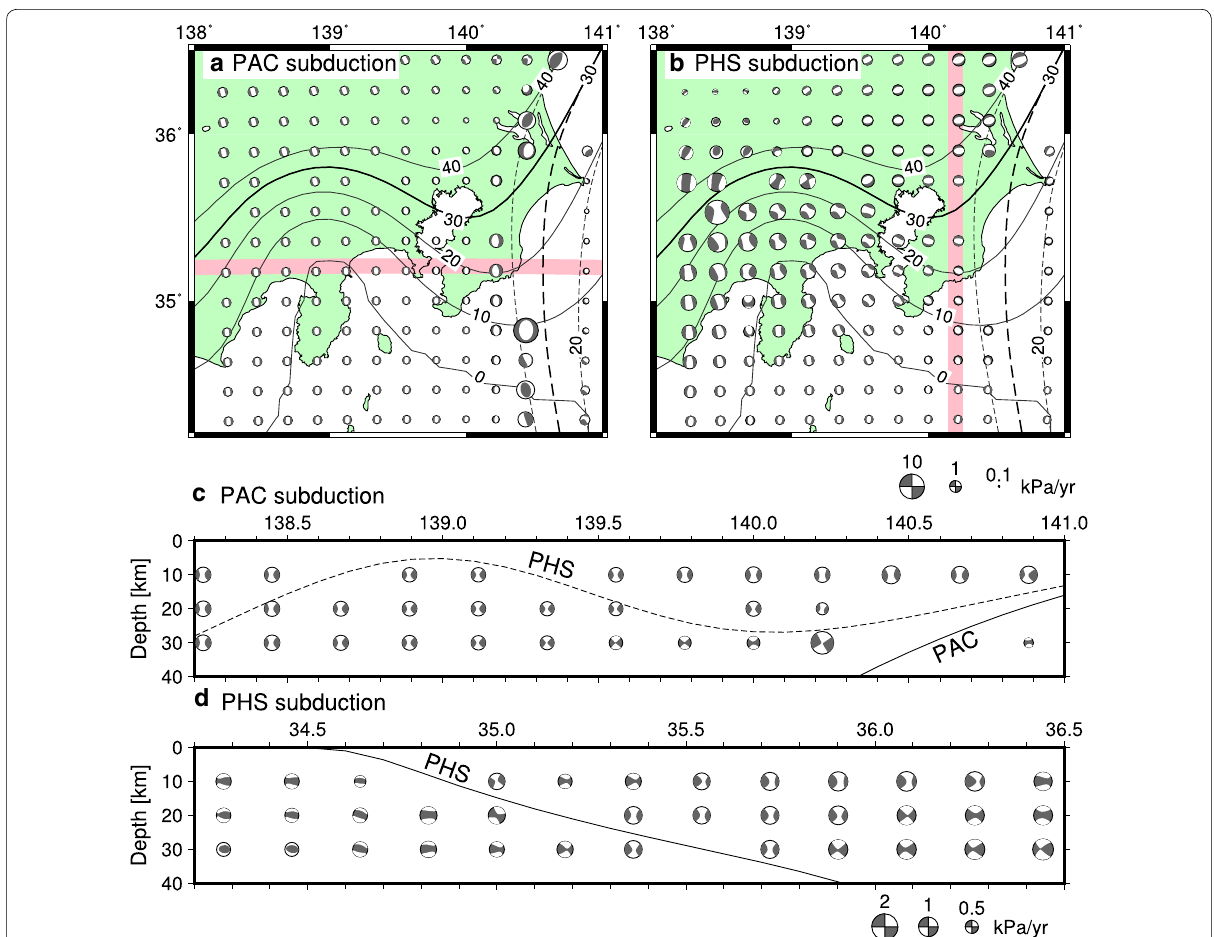
Fig. 5 Contribution of a PAC and b PHS plate subduction to stress rates at 30 km depth. Both in map view. Contribution of c PAC and d PHS subduction to stress rate distribution along pink line in panels a and b , respectively. Both in vertical